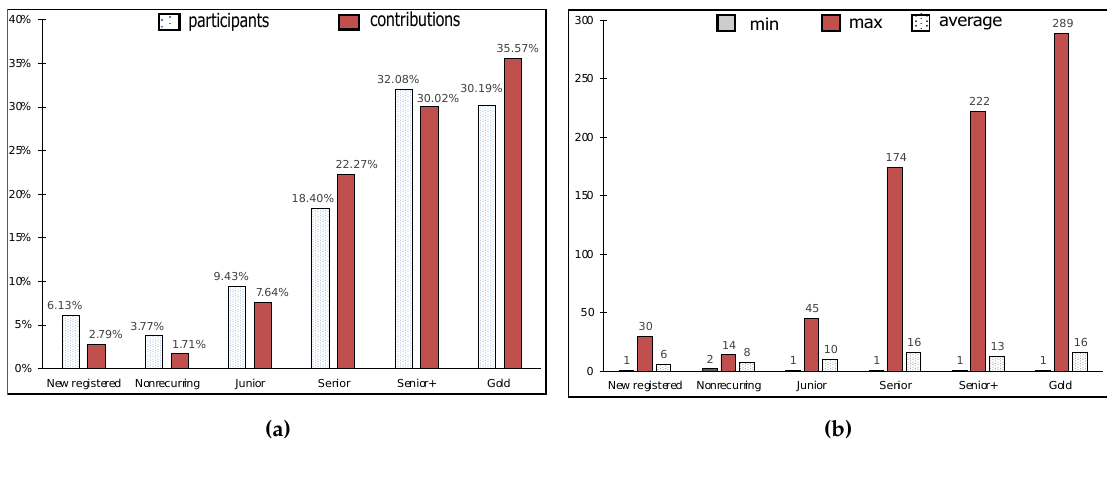
Figure 9. Participants and contributions relative to participant experience. ( a ) Distribution of participants and contributions per group, ( b ) Participant concerns per